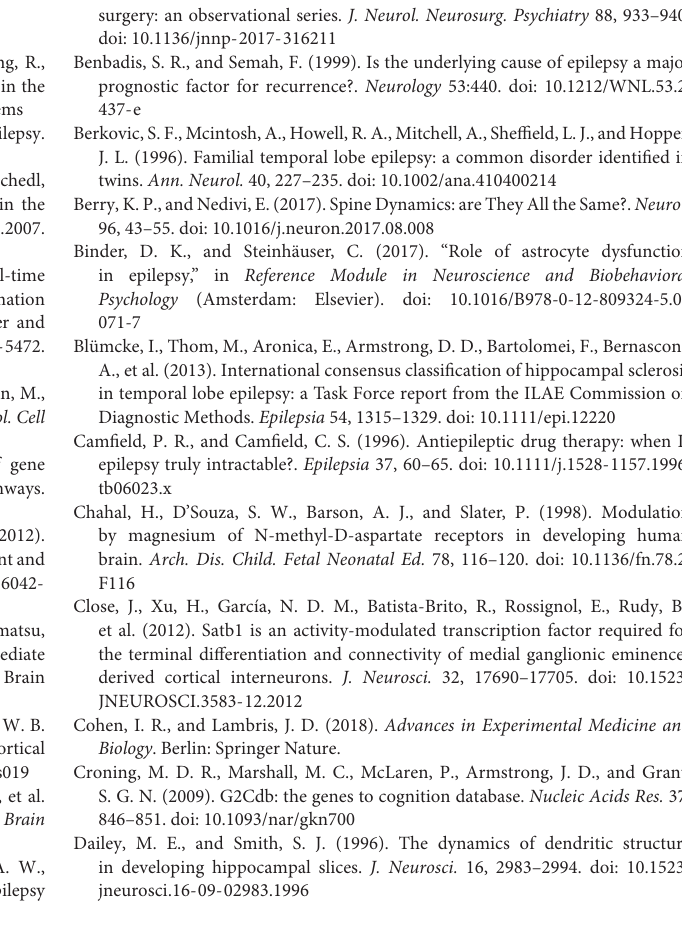
Supplementary Table 4 | List of antibodies used in this study. Information on primary (A) and secondary (B) antibodies used in this study. Supplementary Table 5 | Clinical information of mTLE patients used in RT-qPCR studies. Seizure frequency/duration information was grouped into classes (I-IX) to facilitate downstream analysis. No discrimination was made for epileptic episodes and all types were considered (complex; loss of consciousness; complete or partial tonic seizures; epileptic episodes [auras]). Recurrence was evaluated over a period of 5 years post-resection surgery. Clinical information was correlated with circ_Satb1/2 expression in mTLE (RT-qPCR). When no info was available for a specific patient this was excluded from the analysis. Supplementary Table 6 | Gene expression correlation values of circ_Satb1 and mRNA transcripts in the hippocampus. Correlation analysis was used to show co-expression patterns between circ_Satb1 expression changes and defined groups of transcripts deregulated in the hippocampus. Correlation values (r) are represented in each cell. Both nuclear and cytoplasmic hippocampi samples were used in the analysis. Supplementary Table 7 | GO analysis of mRNA transcripts co-expressed with circ_Satb1 in the hippocampus. GO analysis was performed using the GOrilla interface. The background list included all correlated transcripts (genes) whereas the target list included all transcripts (genes) found to be most strongly co-expressed with circ_Satb1 and among each other. P -value < 0.01 was set as a threshold for the GOrilla analysis. Enrichment was calculated as − log 2 P-value and used in the graphical representation (GO, gene ontology; FDR, false discovery